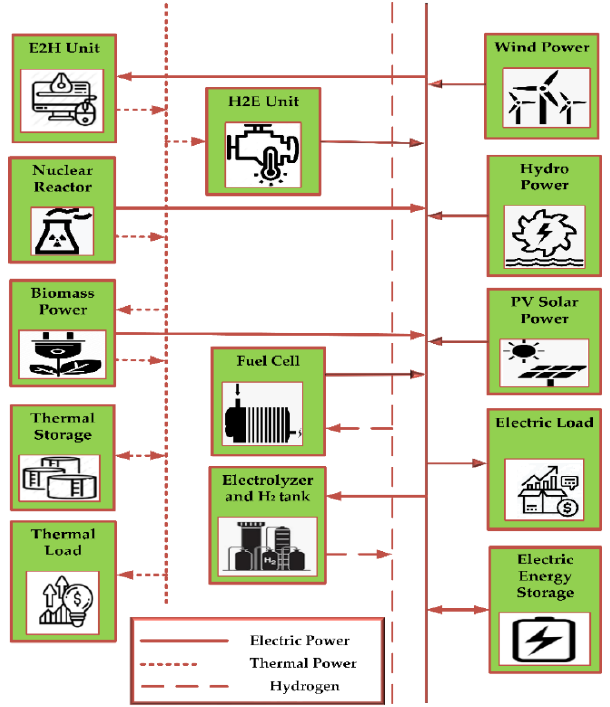
Figure 3. System architecture of MR-based MEG.